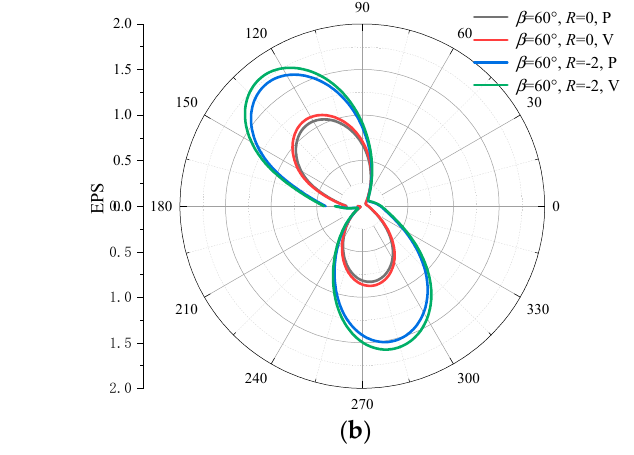
Figure 18. Circumferential EPS field: ( a ) β = 0 ˚ , ( b ) β = 60 ˚ .